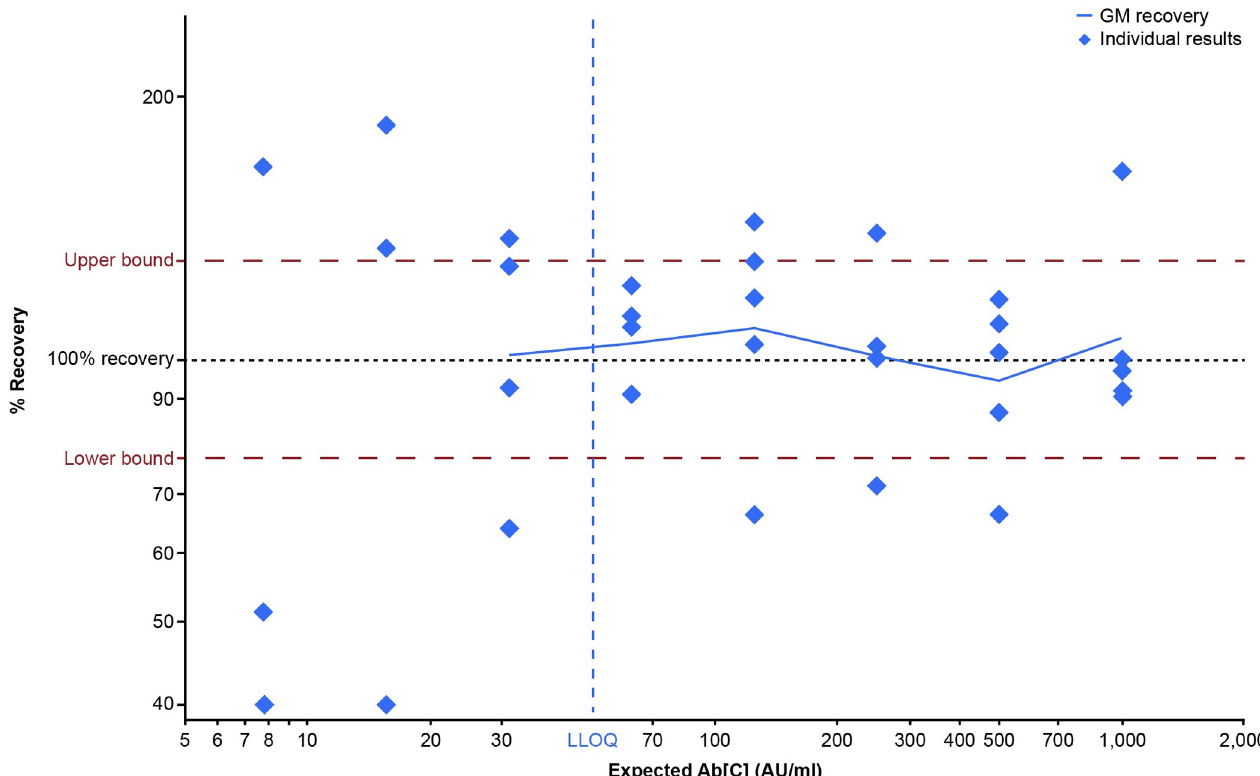
Fig 2. Anti-SARS-CoV-2-neutralizing antibody MNT assay relative accuracy. Overall and individual percentage recovery estimates from eight assay plates in a two-fold dilution series with expected concentrations from 30 to 1,000 AU/ml. The horizontal red dashed lines represent the pre-defined criteria of 77% to 130% for assay accuracy. Ab[C] = antibody concentration; AU = arbitrary units; GM = geometric mean; LLOQ = lower limit of quantitation; SARS-CoV- 2 = severe acute respiratory syndrome coronavirus 2.